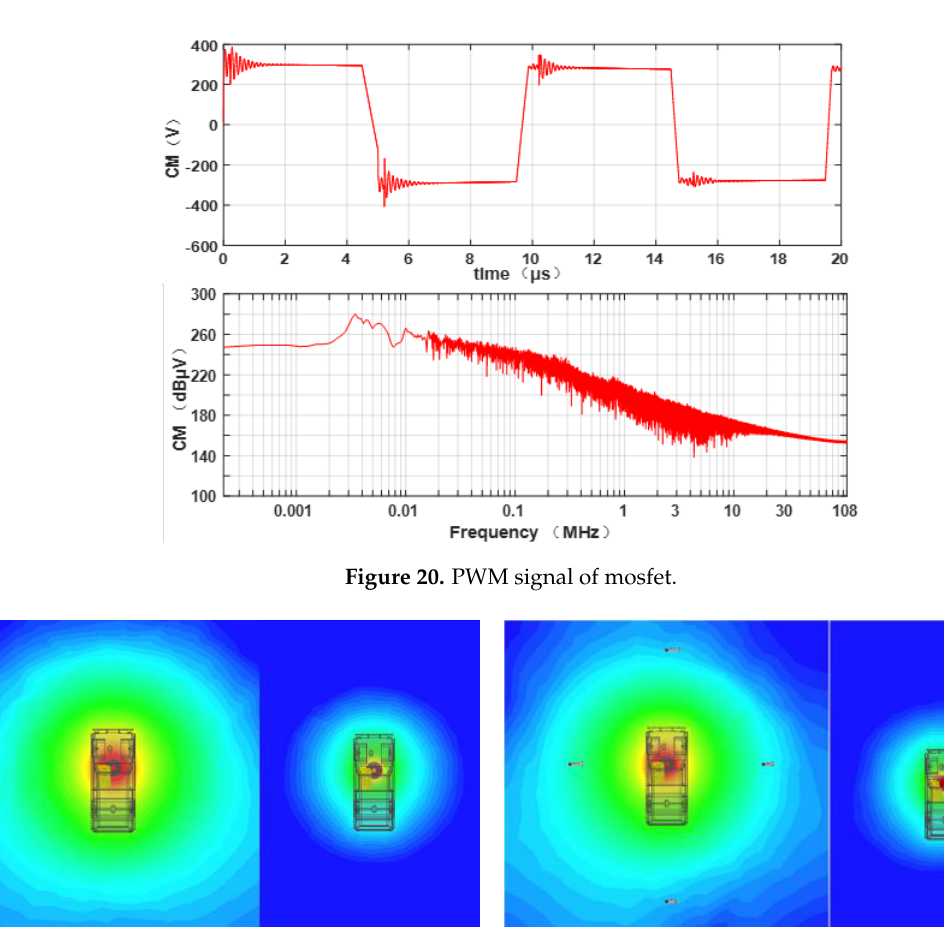
current: ( a ) alignment; ( b ) 30% offset.